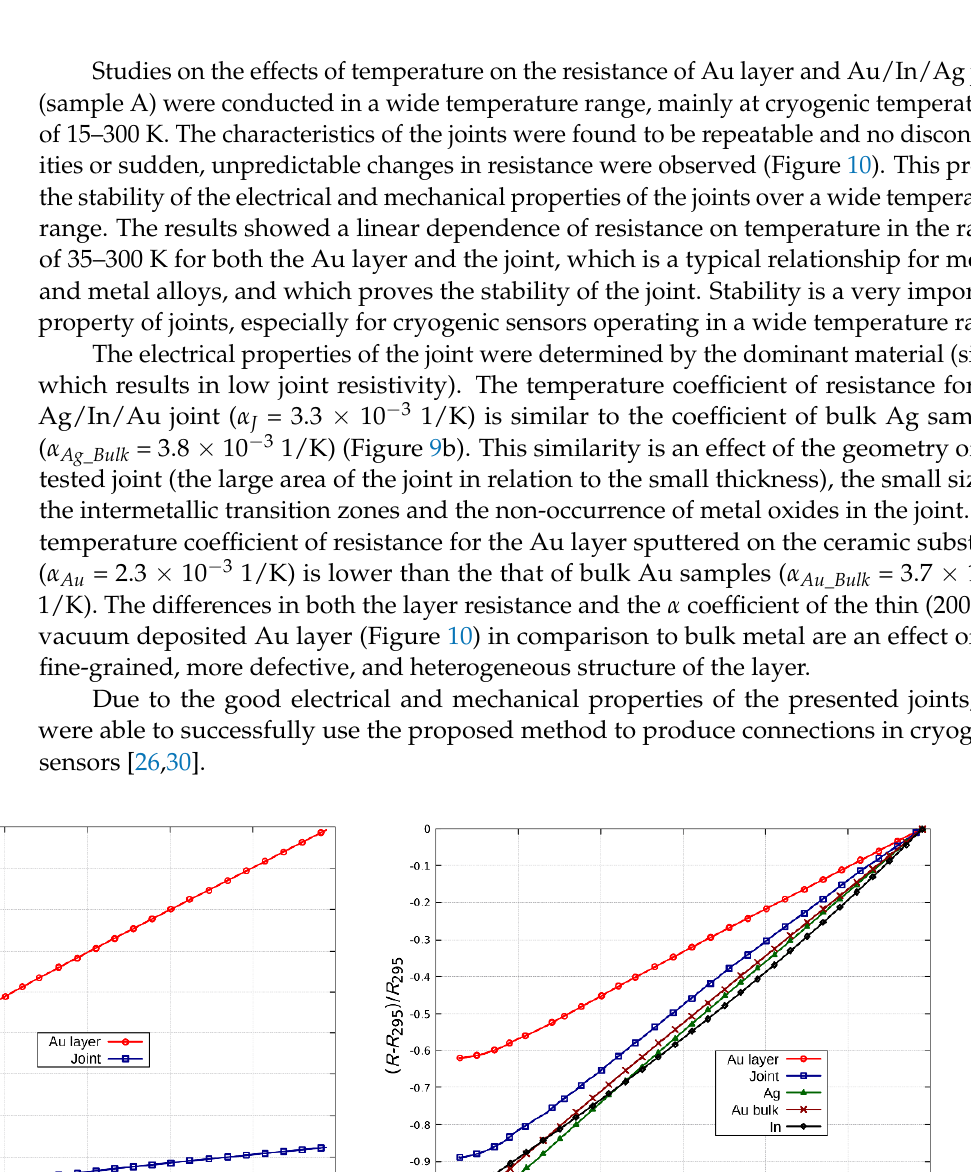
Figure 11. Results of strength testing joints for the tangential component F T and the normal force component F N . In the second part of the electrical tests, the electrical parameters of the samples were measured at room temperature based on analysis of the Joule heat flux density generated in the sample. The Au layer and Au/In/Ag (sample A) joints were integrated on a homo- geneous ceramic substrate with high thermal conductivity. Such substrates are often used to build cryogenic sensors, in order to eliminate the temperature gradient in the sensor while ensuring good thermal anchoring and electrical insulation.